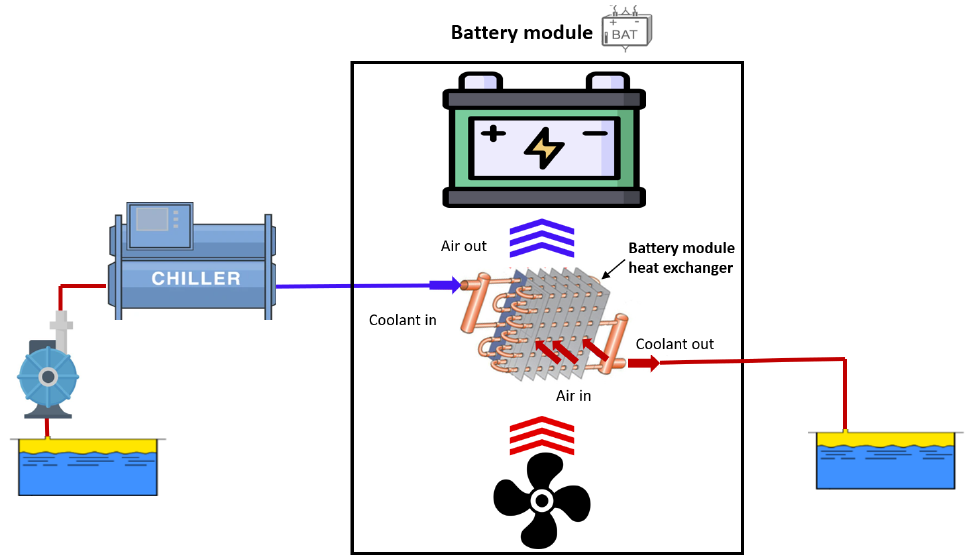
Figure 2. Framework of the battery cooling